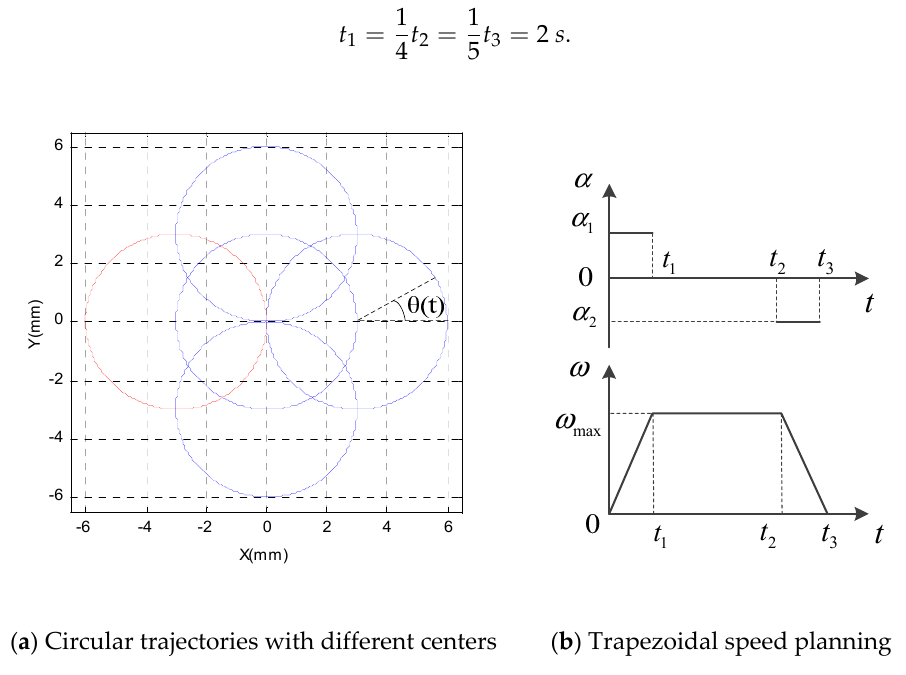
Figure 3. Different circular trajectories with radii of 3 mm. Figure 3. Di ff erent circular trajectories with radii of 3